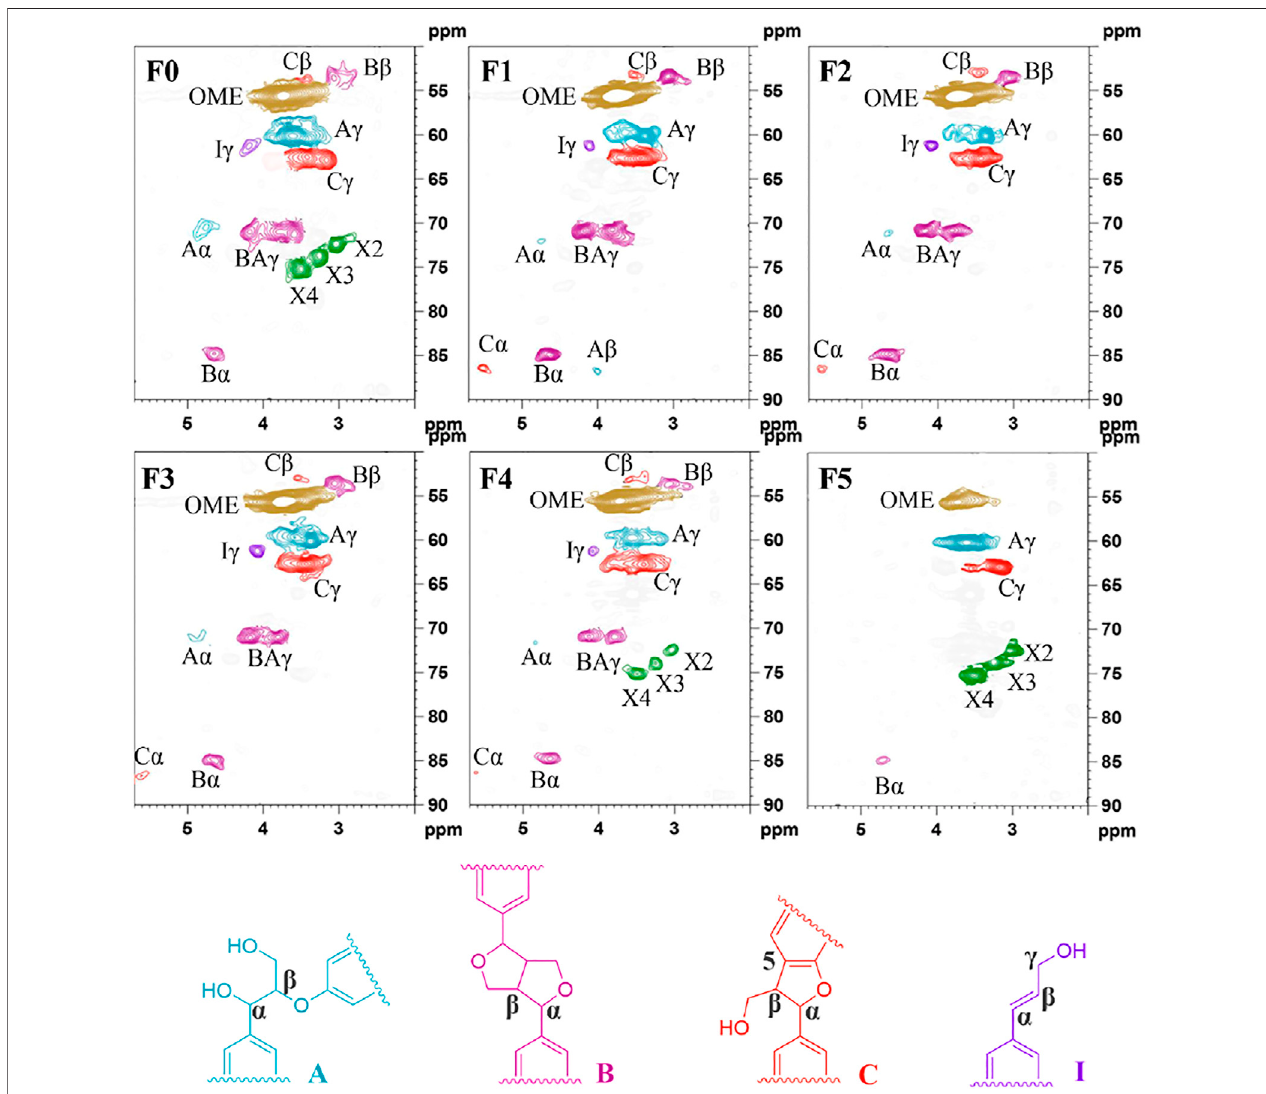
FIGURE 3 | The side-chain of lignin samples in the 2D HSQC NMR spectra.